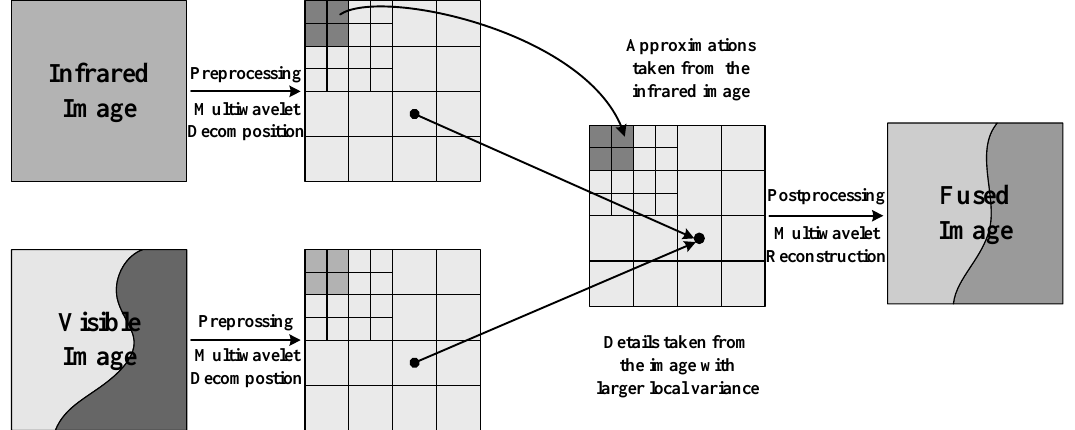
Figure 1. The multiwavelet-based algorithm for IR and VIS image fusion. Only three levels of decomposition are